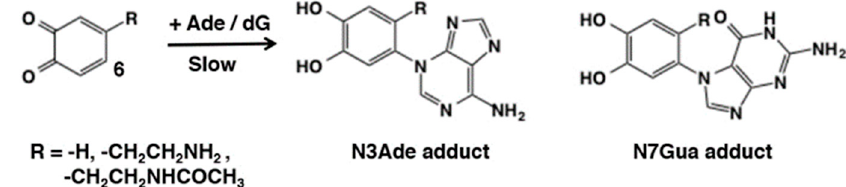
Figure 12. Reaction of o -quinones with DNA bases [58]. These adducts are isolated in the reduced